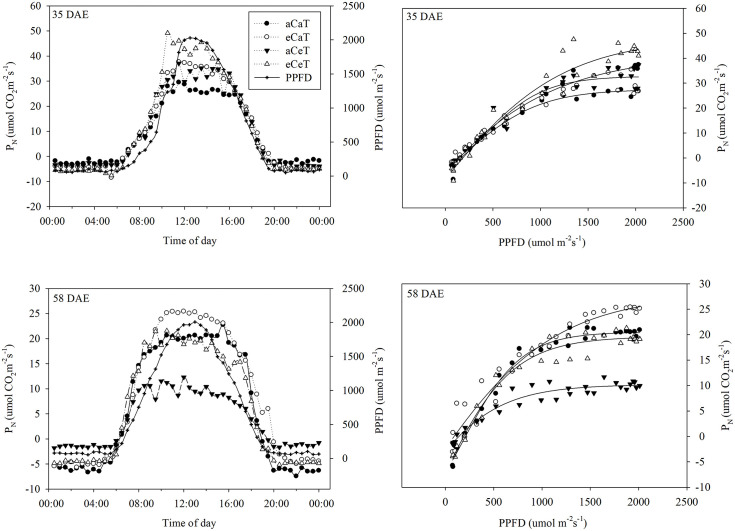
The diurnal net photosynthetic rate (PN) and Photosynthetic Photon Flux Density (PPFD) of potato plants at 35 DAE and 58 DAE under different conditions of CO2 and temperature.